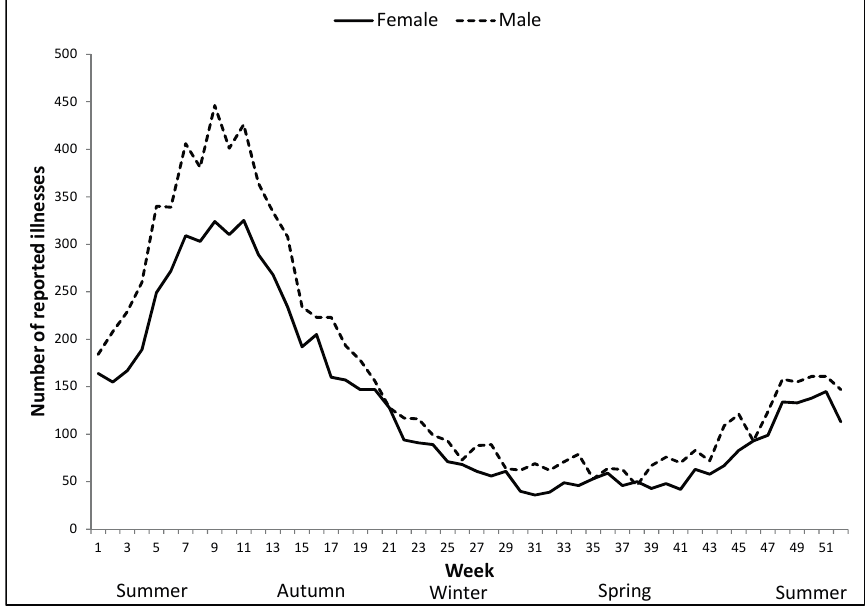
Figure 1. Average annual rates of reported cryptosporidiosis per 100,000 population across Australia in the whole population and in children <5 years, 2001–2012.